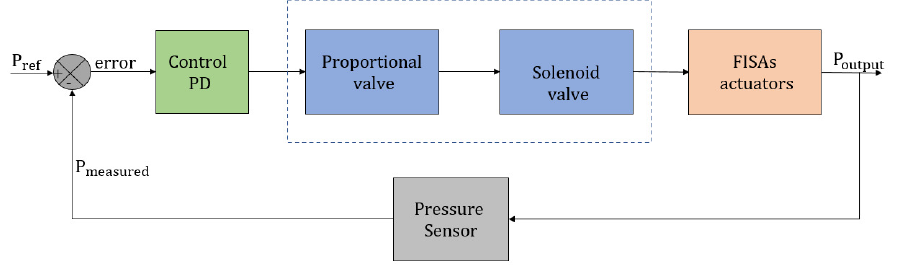
Figure 5. FISAs pressure sensing in a closed-loop control scheme.